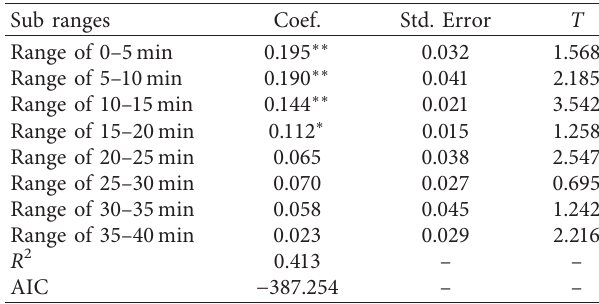
Table 8: Subrange estimation using the SAR model.